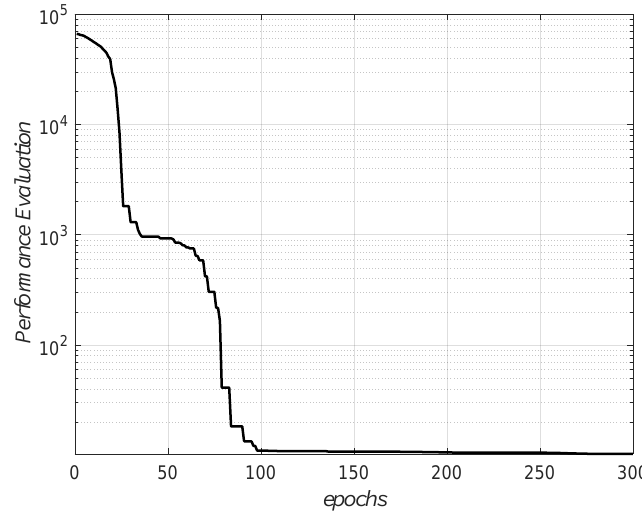
Figure 4. The MSE of the training phase.